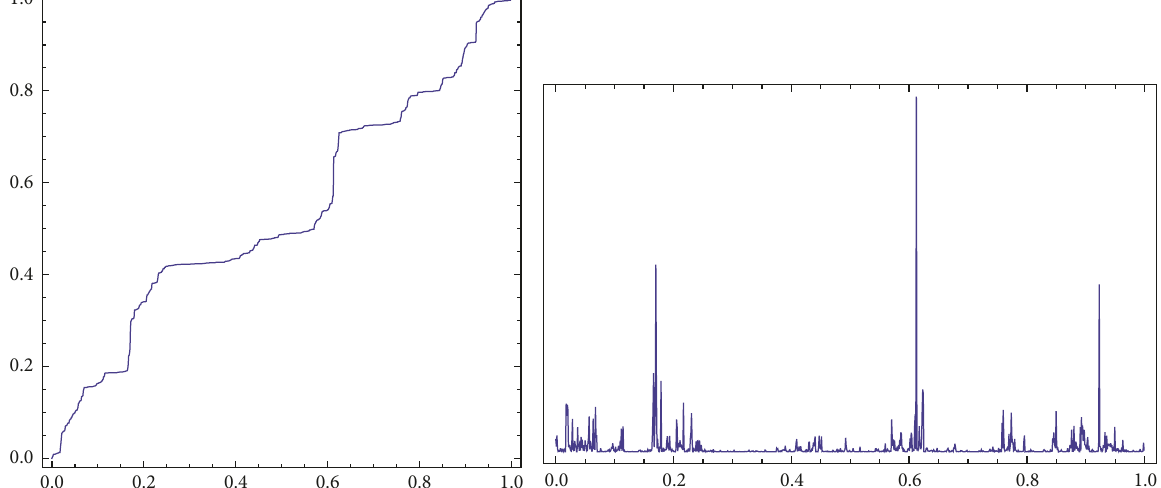
Figure 2: Left: one example of random mass distribution function, generated as a random homeomorphism of the interval [0,1] . Right: the derivative of this function, giving the mass